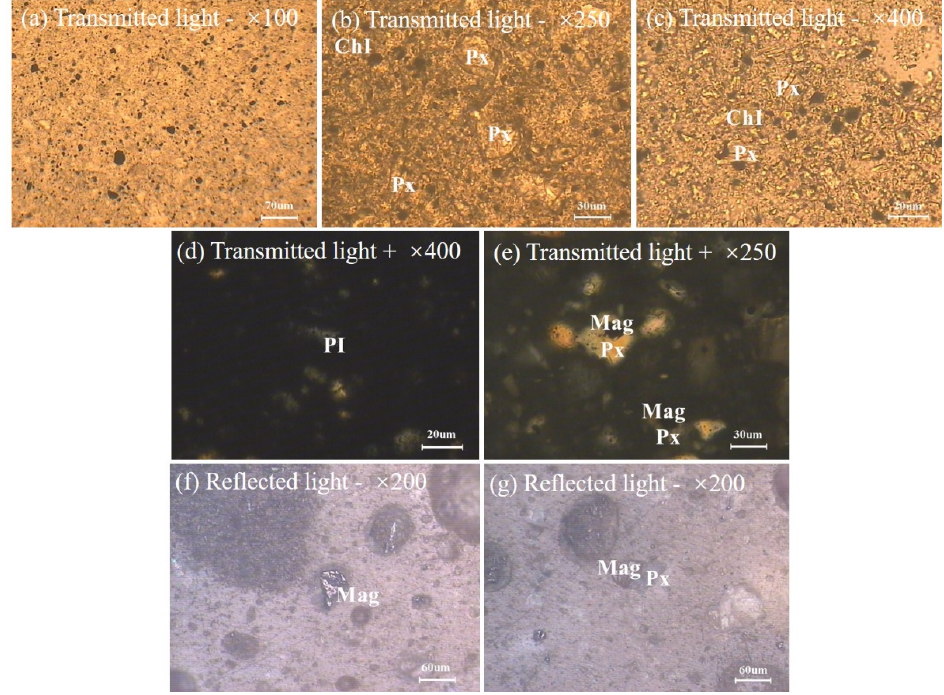
Figure 2. Microfacies of the OB; Px is pyroxene, PI is feldspar, Chl is chlorite, and Mag is magnetite.